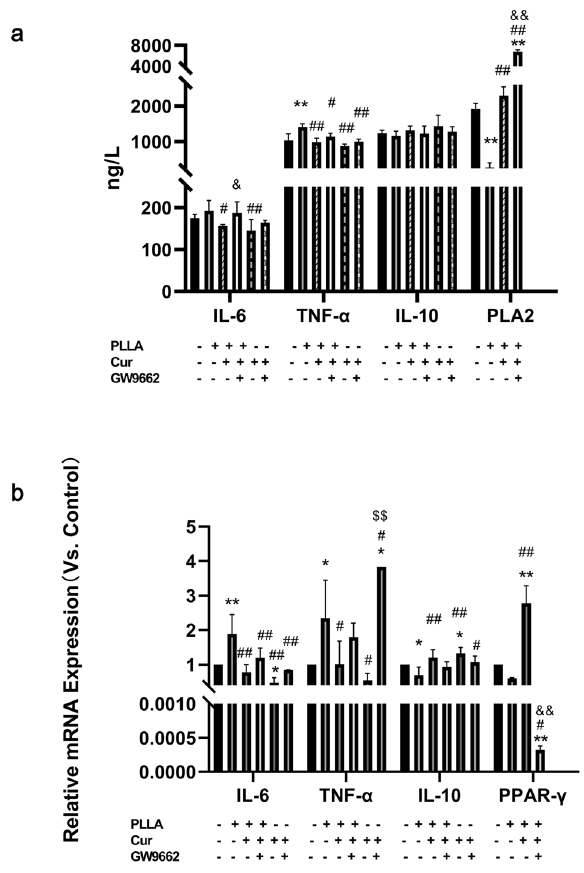
Fig. 4 Measurement results of in fl ammatory cytokines and PPAR γ pathway signal by ELISA and RT-qPCR. a The release level of IL-6, TNF- α , IL-10 and LP-PLA2 detected by ELISA. The level of IL-6 and TNF- α in PLLA group signi fi cantly increased while comparing to the Con group, and decreased while comparing to the PLLA + Cur group. Compared with the PLLA + Con group, the levels of Lp-PLA2 were decreased in PLLA group. Compared with PLLA group, Lp-PLA2 increased in PLLA + Cur group. And compared with PLLA + Cur group, Lp-PLA2 increased in PLLA + Cur + GW9662 group. There were no signi fi cantly differences among each group of release levels of IL-10. b The mRNA level of IL-6, TNF- α , IL-10 and PPAR γ detected by RT-qPCR. Compare to Con group, the levels of IL-6 and TNF- α mRNA signi fi cantly increased in PLLA group and decreased in PLLA + Cur group; the level of IL-10 and PPAR- γ mRNA signi fi cantly decreased in PLLA group and increased in PLLA + Cur group. In contrast, the level of PPAR- γ mRNA decreased in PLLA + Cur + GW9662 group while compare to PLLA + Cur group. (Compared with Con group, ** p < 0.01, * p = < 0.05, respectively. Compared with PLLA group, ## p < 0.01, # p = < 0.05, respectively. Compared with PLLA + Cur group, && p < 0.01, & p = < 0.05, respectively. Com- pared with Cur group, $$ p < 0.01, $ p = < 0.05, respectively)